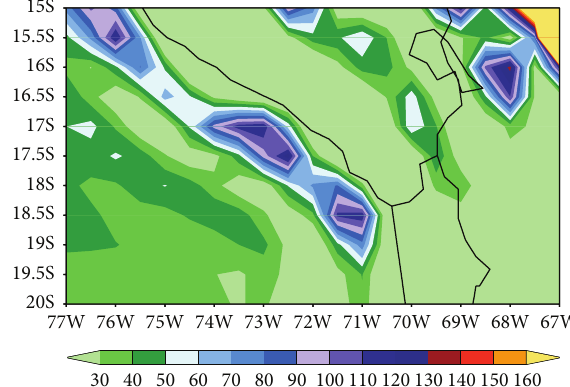
Figure 2: JJA CFS reanalysis climatology 1979–2009 precipitation shaded (units: mm/season).